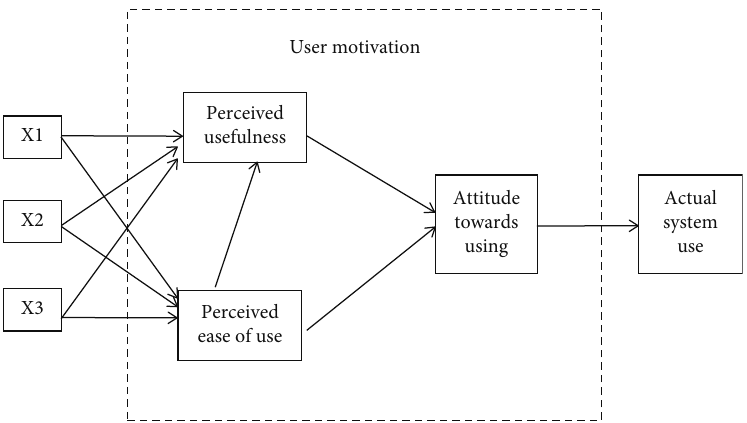
Figure 5: Original technology acceptance model